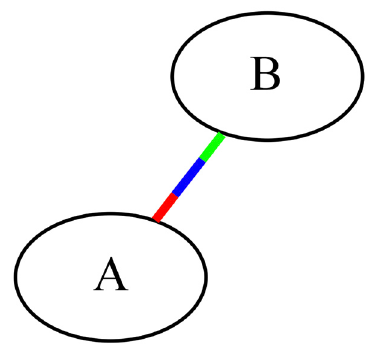
Figure 11. Example of an edge rendered as colored segments in